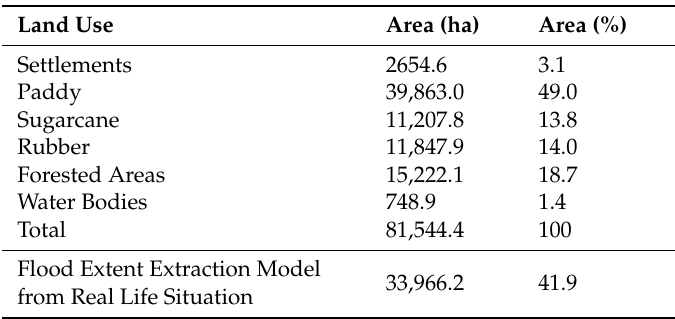
Figure 8. Superimposed image of the flood extent model and the spatial flood susceptibility model. Table 8. Area of land use attributes and the magnitude of flood extent